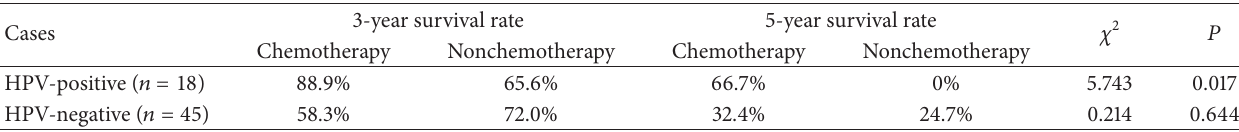
Table 4: The impact of HPV infection on the prognosis of patient with chemotherapy or without